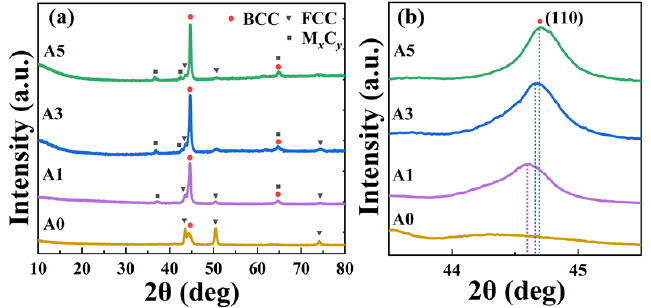
Figure 7. ( a ) XRD analysis of the A0, A1, A3, and A5 samples; ( b ) patterns at 41°–45° at a larger magnification.